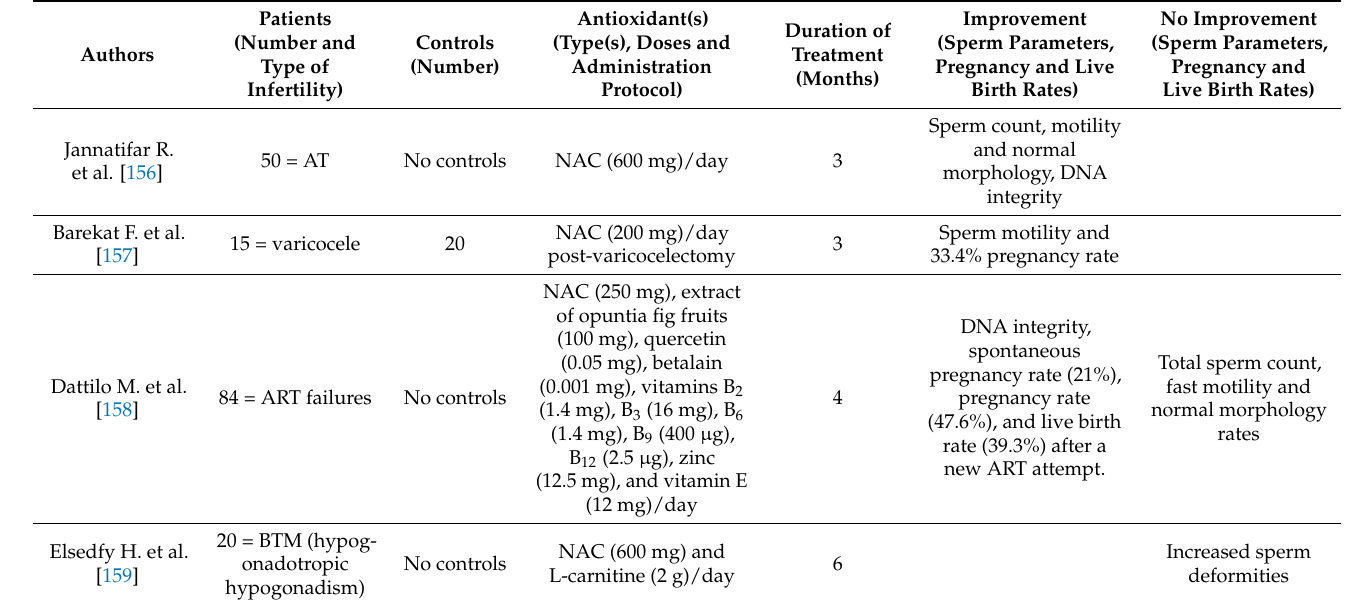
Table 2. Summary of the main results obtained in the 4 papers focusing on the effect of N -acetylcysteine (NAC) administra- tion for the treatment of male